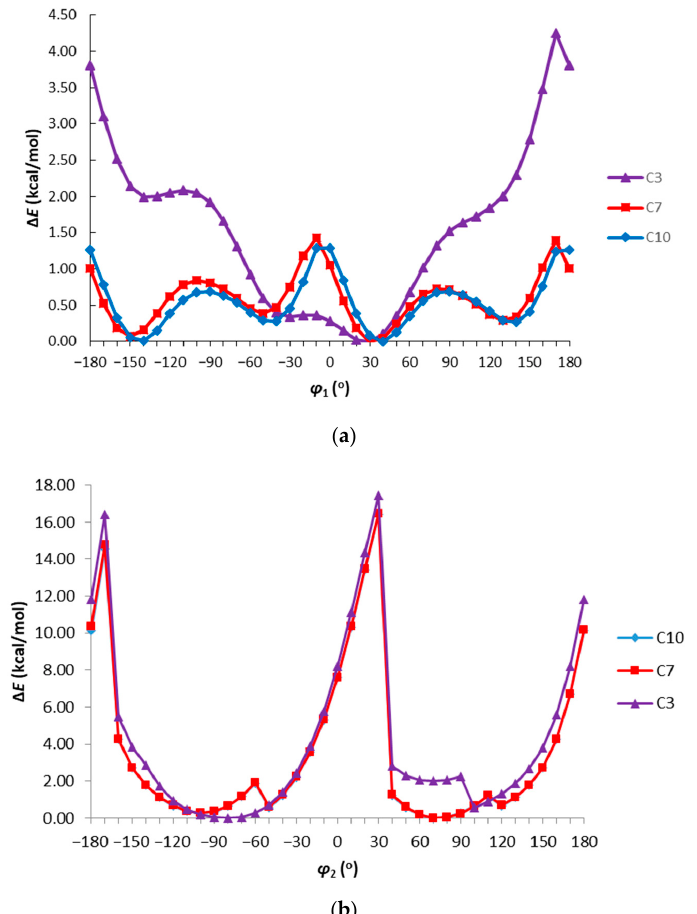
Figure 2. The energy e ff ect of the free rotation for the torsion angle ( a ) ϕ 1 = N4–C3–C61–N(C)62 and ( b ) ϕ 2 = C3–N4–C41–C42 calculated for C3, C7, and C10 using the semiempirical AM1